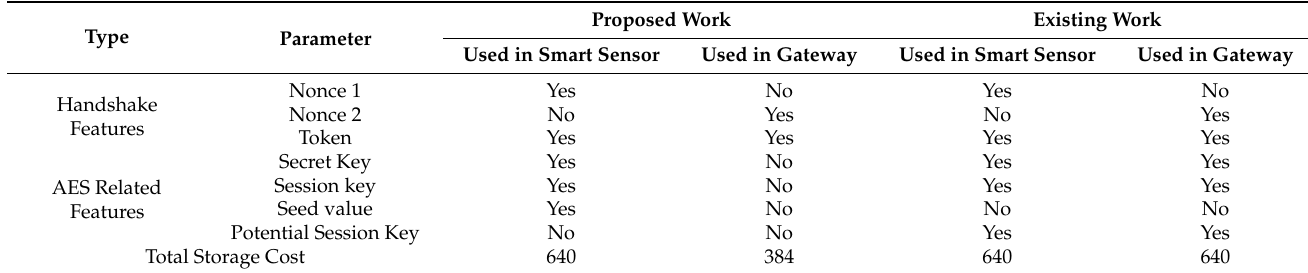
Table 2. Storage cost of the proposed PEOS and existing payload-based encryption